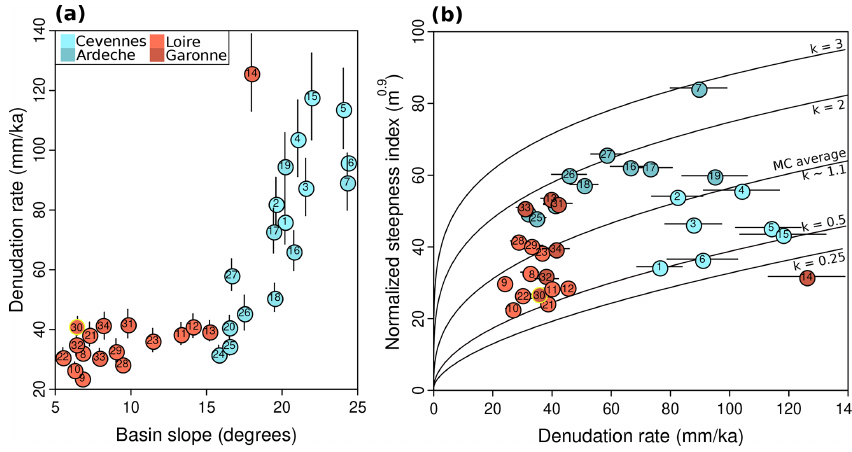
Figure 6. (a) Comparison between erosion rate and basin slope. Symbols are colored according to the location of the measurements (Cévennes, Ardèche, Loire, and Garonne). Basin CDX-30 is a very small catchment when compared to the rest of our dataset and is col- ored in yellow. (b) Comparison between normalized channel steepness index and denudation rates. Black lines correspond to the theoretical relationship between denudation rate and steepness index computed from Eqs. (8) and (10) for various values of the discharge variability parameter k . We set the critical shear stress τ c = 40Pa and the erodibility coefficient k e = 8 × 10 − 13 m 2 . 5 s 2 kg − 1 . 5 . We use a regionally averaged value for runoff of R = 650mma − 1